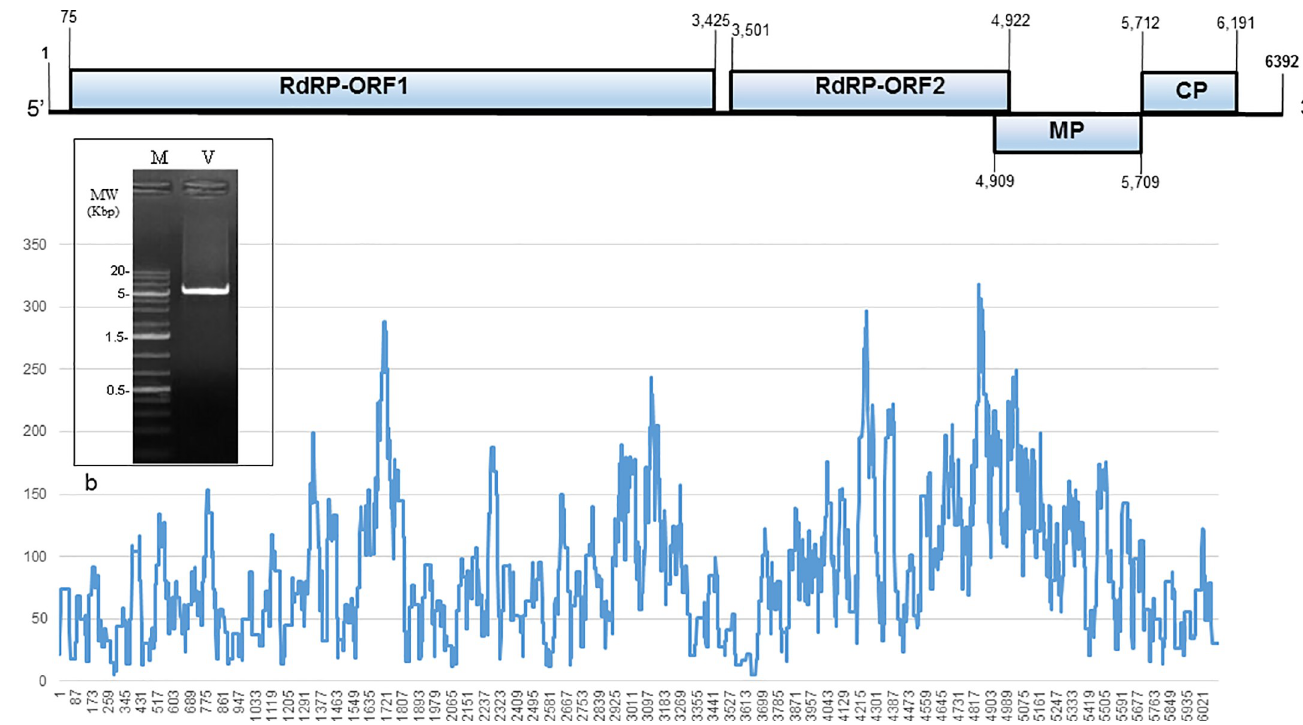
Fig 5. ToBRFV adhering to a bumblebee. a. A diagram of ToBRFV genome organization. b. RT-PCR of ToBRFV starting at position 264 to 5,531 covering ~82% of the genome. c. Distribution of NGS reads along the ToBRFV genome. RdRP, RNA dependent RNA polymerase; MP, movement protein; CP, coat protein; M, molecular size marker; V, RT-PCR amplification of ToBRFV